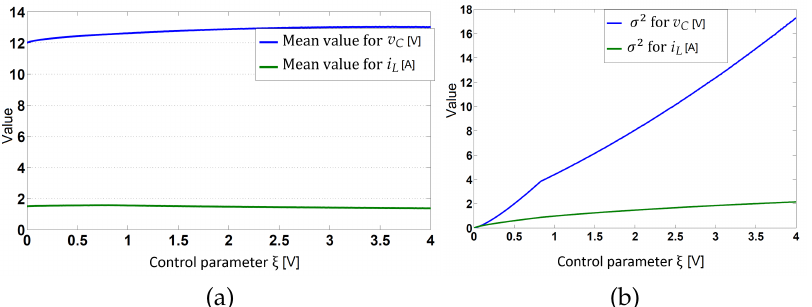
Figure 17. Regulation indexes mean and variance when hysteresis parameter ξ is varied: ( a ) mean values and ( b ) variance.